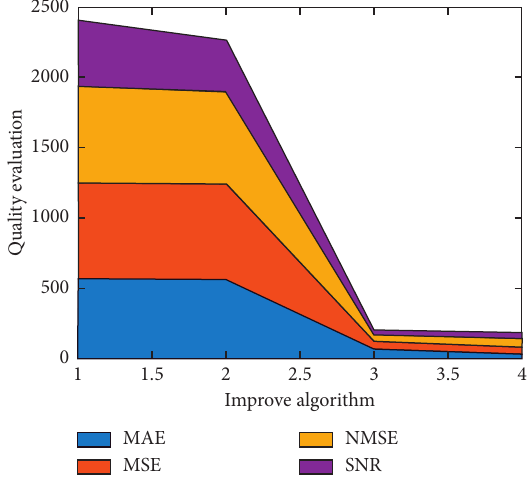
Figure 1: Quality evaluation of the improved algorithm.